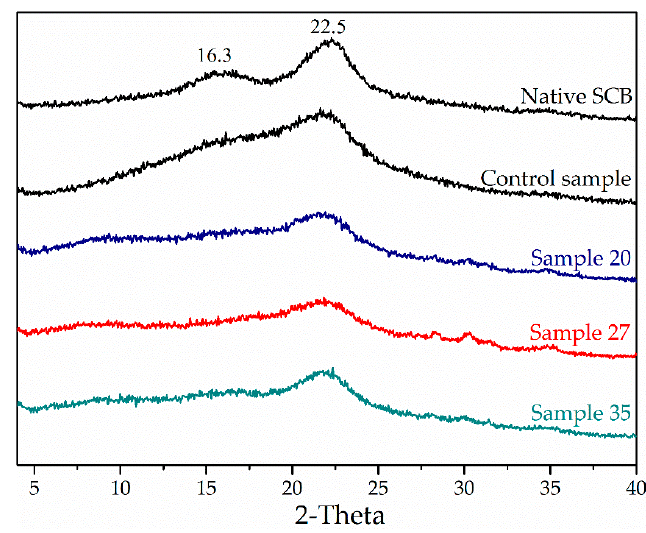
Figure 3. XRD patterns of native SCB, the control sample and SCB acetate (sample 20), propionate (sample 27) and butyrate (sample 35).